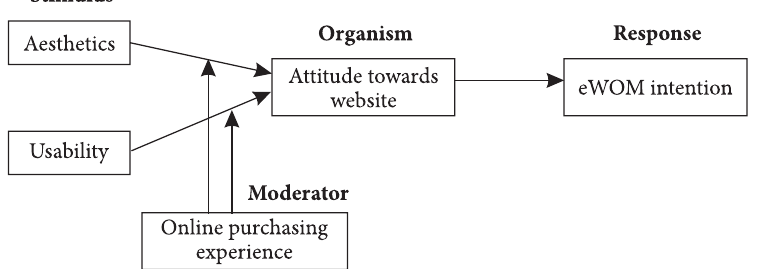
Figure 1. Hypothesis testing of structural model